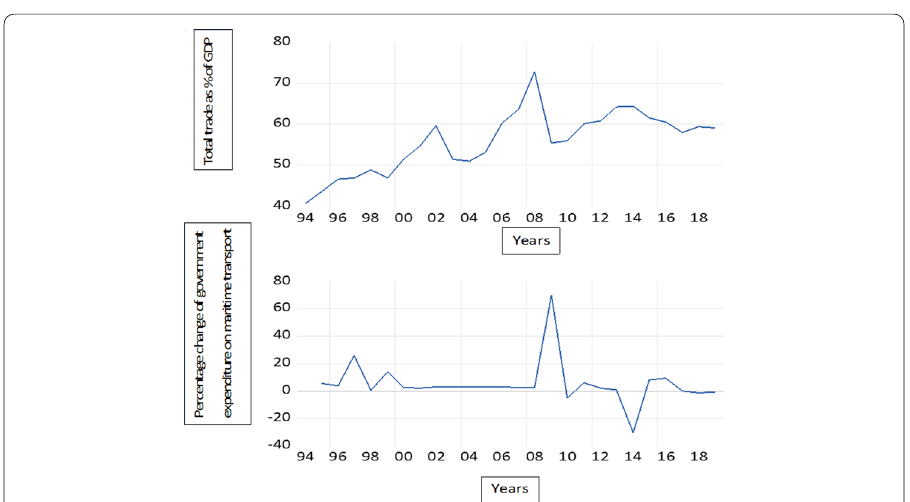
Fig. 1 Trends of total trade and maritime transport financing from 1994–2019. Source: World bank 2020 and National treasury,